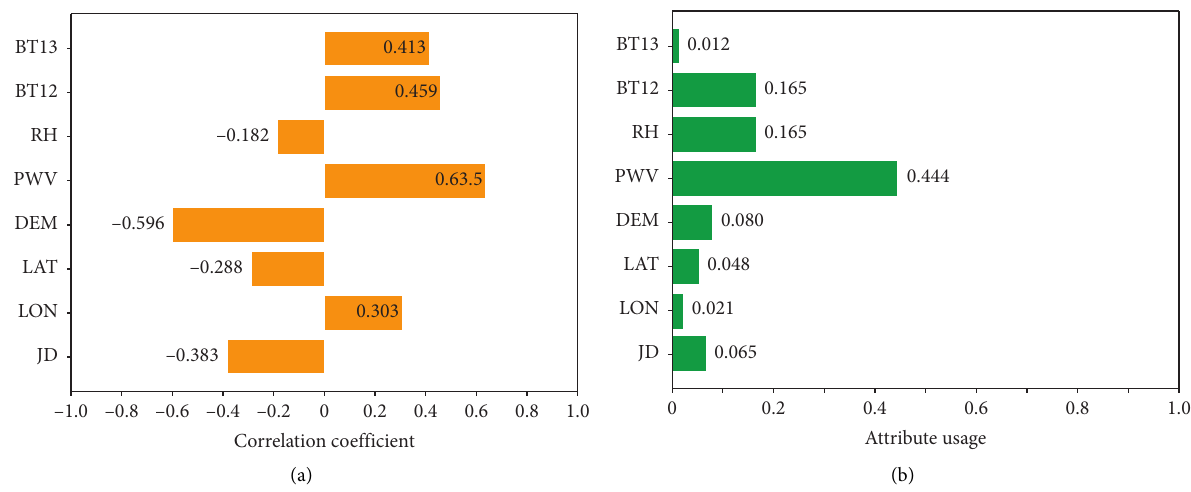
Figure 4: (a) Relative variable importance identified by Pearson correlation coefficient and (b) RF variable